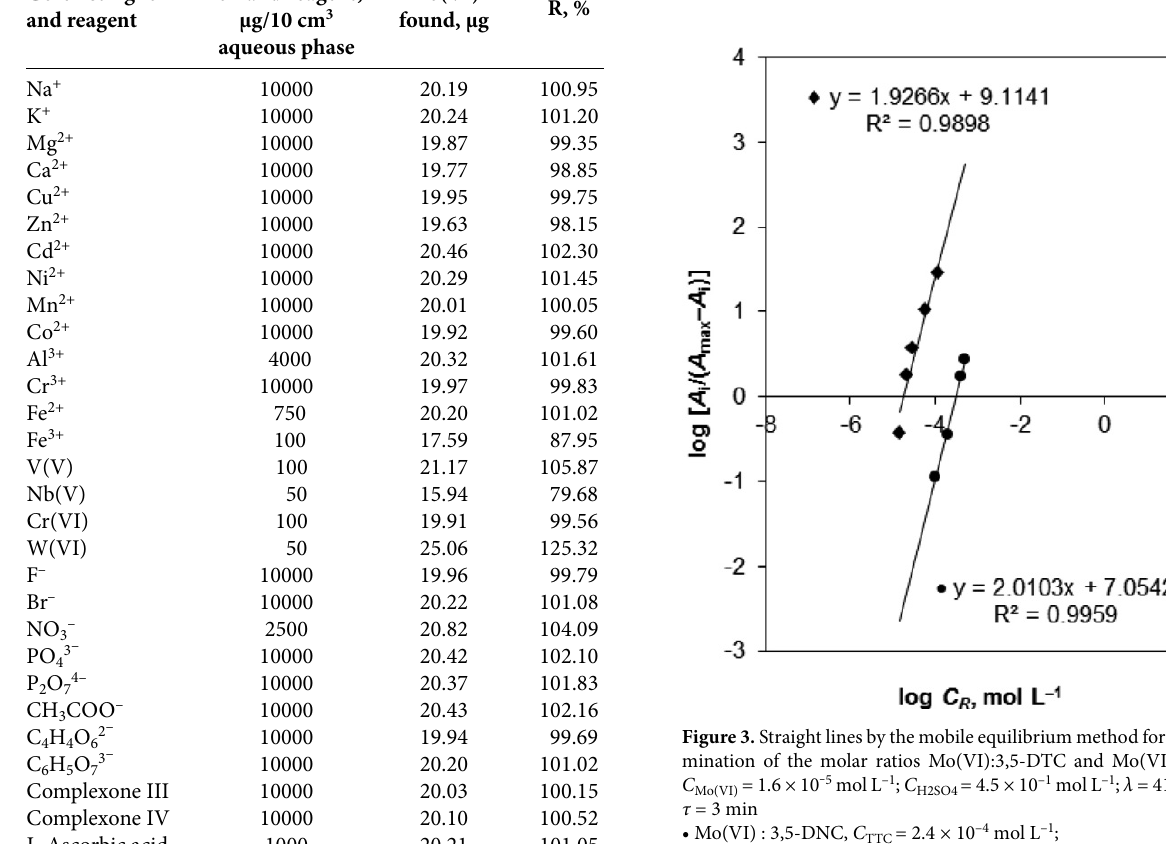
• Mo(VI) : 3,5-DNC, C TTC = 2.4 × 10 –4 mol L –1 ; ◆ Mo(VI) : TTC, C 3,5-DNC = 1.2 × 10 –3 mol L